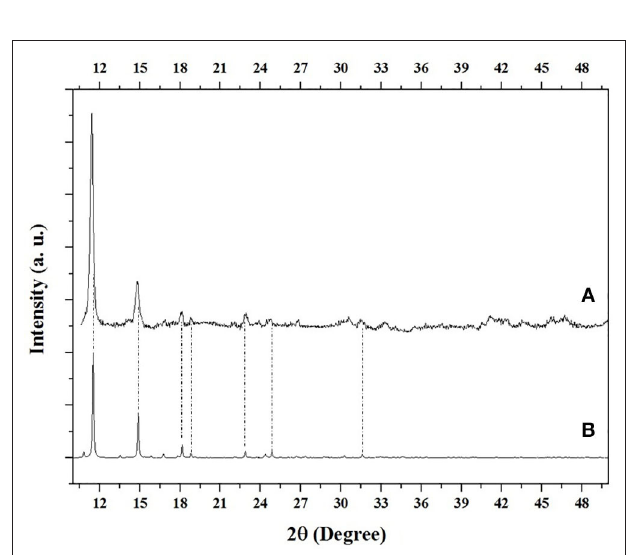
FIGURE 4 | MOF theoretical diffraction comparison (A) experimental and (B)